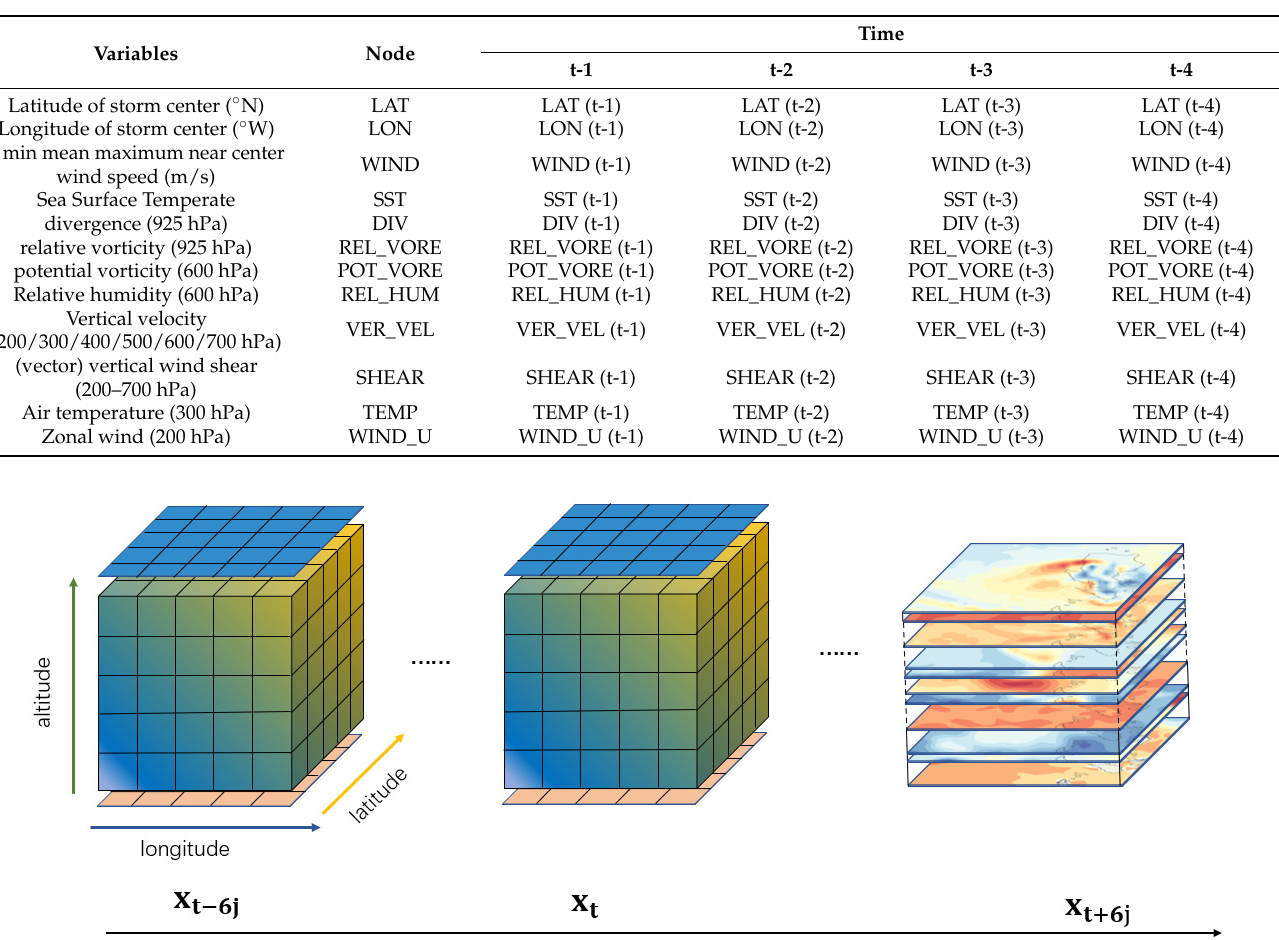
Table 1. Large-scale environmental conditions as predictors of TC formation in the WNP region. Node represents the name of abbreviations. In this case, t-1 represents the last 6 h. t-2 represent the last 12 h, etc.